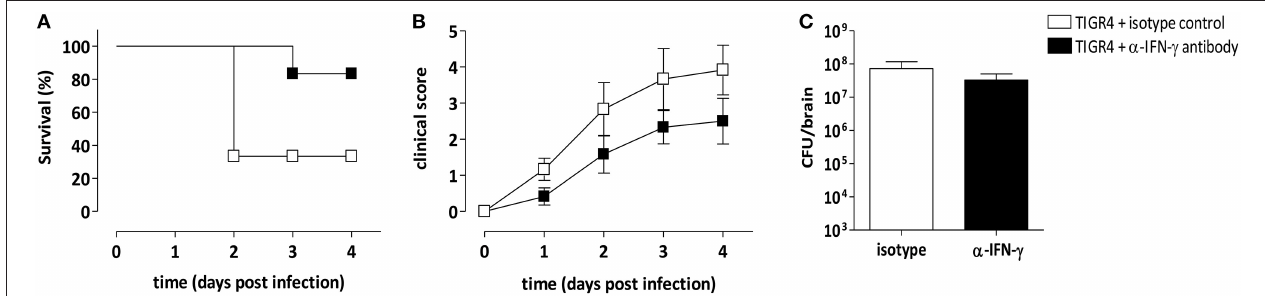
FIGURE 5 | IFN- γ specific monoclonal antibody treatment. Mice were infected by the intracranial route with 3 × 10 4 CFU of S. pneumoniae TIGR4 and administered with a neutralizing anti-IFN- γ antibody (black) or with an isotype control antibody (white) at the time of the bacteria inoculum. To analyze the role of IFN- γ in pneumococcal meningitis, animals were monitored up to 4 days post infection. Data are from two independent experiments with 4 mice/group. (A) Kaplan-Meier curve of mouse survival. Results were expressed as percentage of survival over time. (B) Clinical score was evaluated using a scale for severity of disease, from 0 (normal) to 5 (moribund), and reported as mean value ± SEM. (C) Bacterial load estimation in brain of mice 48h post infection. Mean values ± SEM are